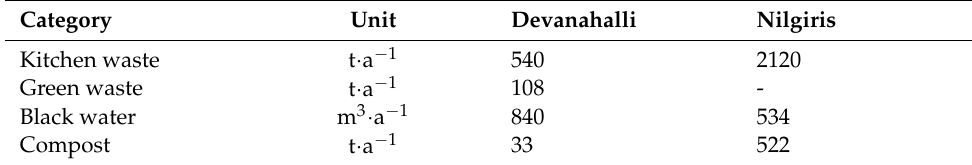
Table 3. Mass balances from the two case studies in Devanahalli and Nilgiris in 2020. Category Unit Devanahalli